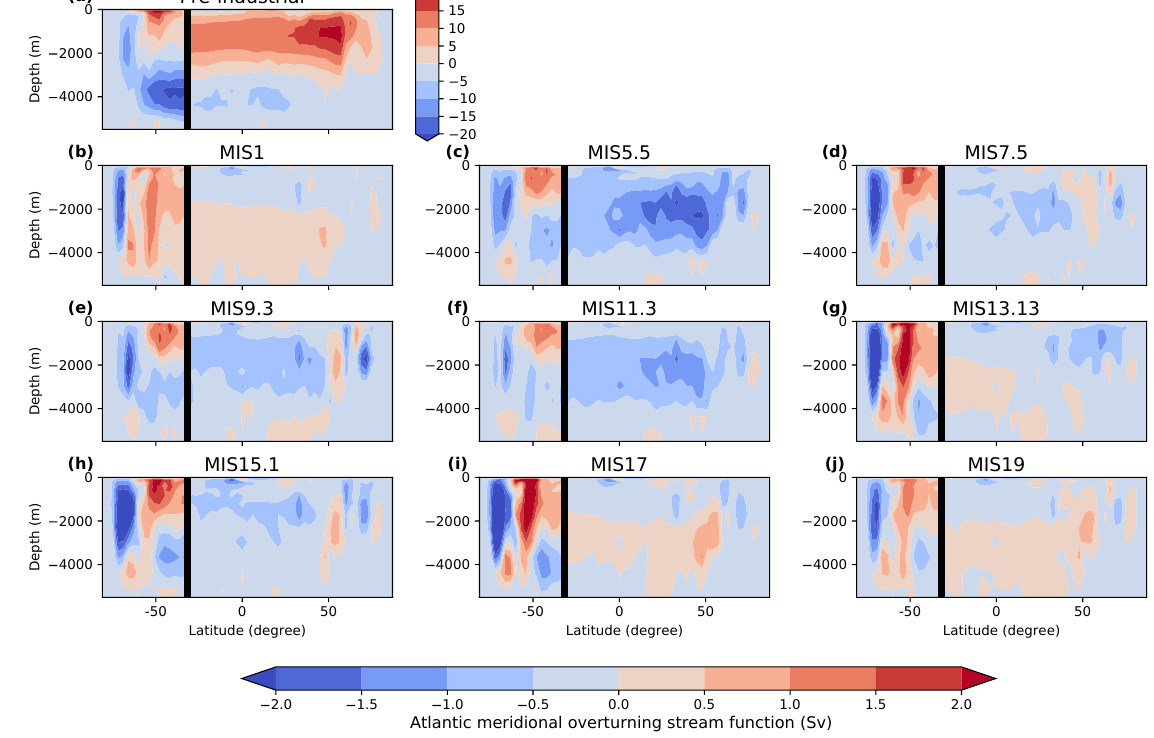
Figure 5. Meridional overturning circulation (Sv) in the Southern Ocean and in the Atlantic Ocean north of 32 ◦ S in (a) the pre-industrial control simulation and (b–j) the interglacial simulations of the OC series with fixed vegetation and fixed ice sheets, in anomalies with respect to the pre-industrial control simulation. The vertical black line indicates the limit between the Southern Ocean south of 32 ◦ S and the Atlantic Ocean north of 32 ◦ S.